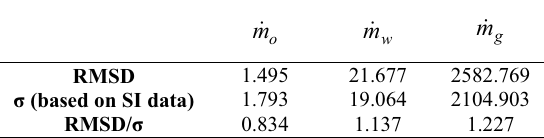
Table 5. Estimate of the standard deviations of the mass flow rate noises